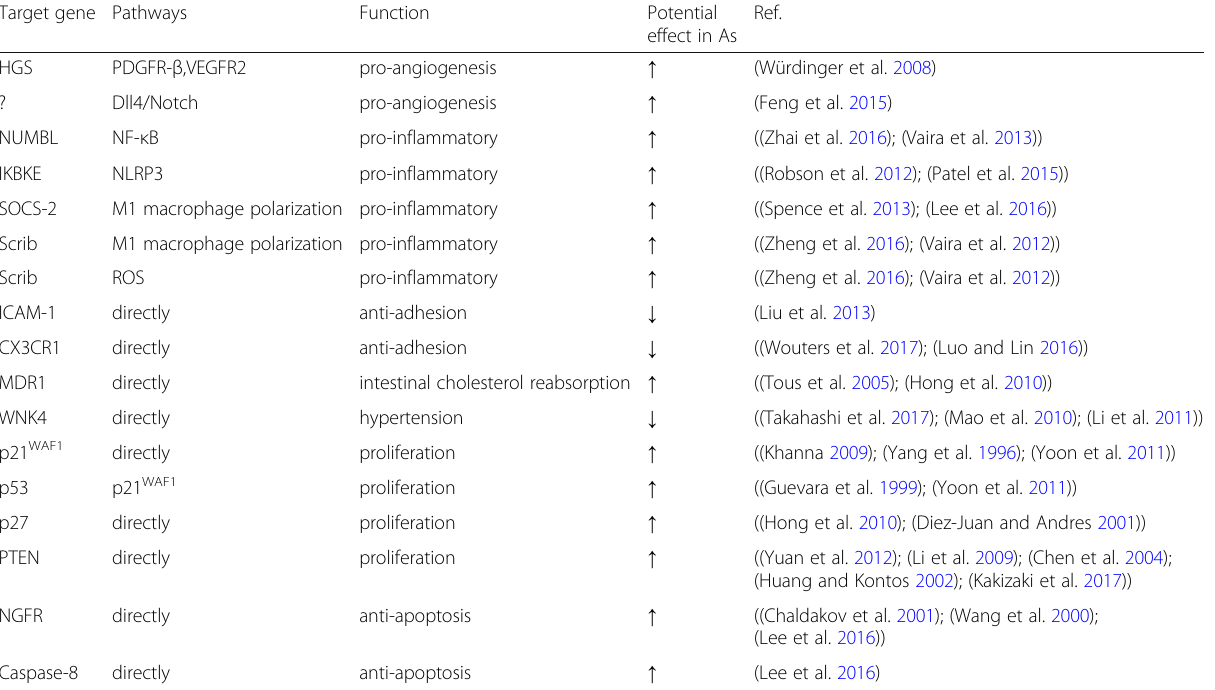
Table 2 The target genes of miR-296 and its roles in atherosclerosis Target gene